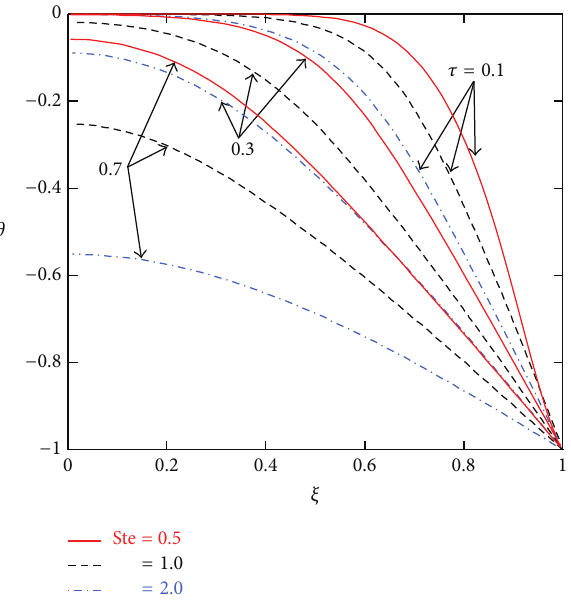
Figure 4: Transient temperature profiles in slab with temperature- dependent specific heat for 𝐶 1 = 0 , 𝐶 3 = 0.5 , 𝛽 1 = −10 , 𝛽 2 = 0 , = 1 , and (𝑀,𝑁) = (40,4) with 𝜉 -domain division into eight 𝜃 0 subdomains (i.e., 𝐺 = 1/8 ).